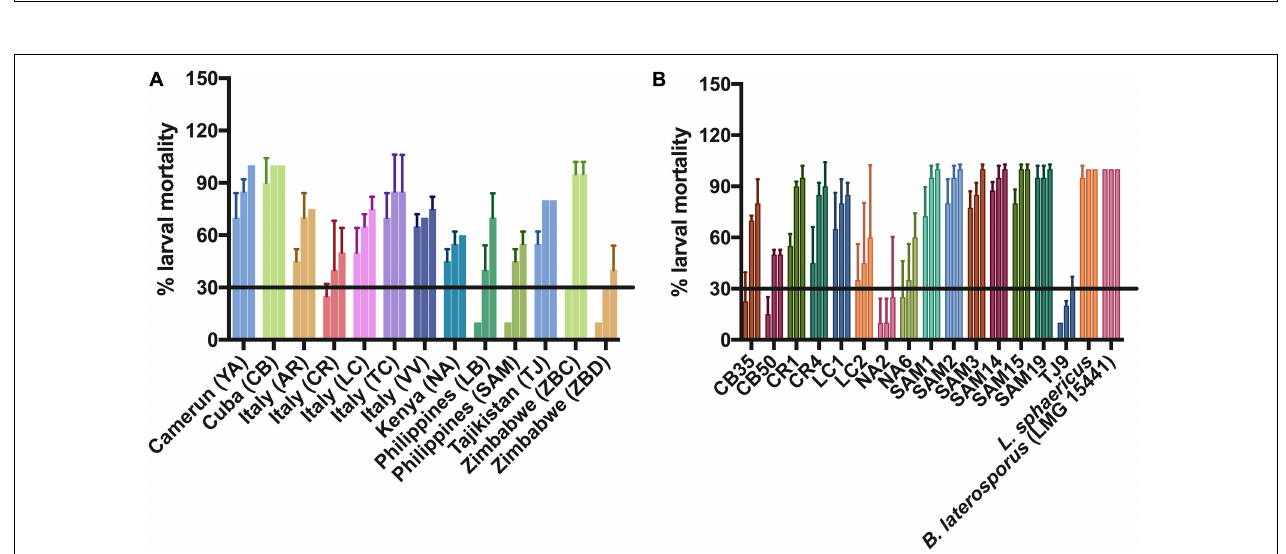
FIGURE 2 | Percentage of Ae. albopictus larval mortality at 24, 48, and 72 h after treatment with mixtures of cells and spores of cultures originating from the inoculum of 13 soil samples (A) or of single bacterial isolates (B) . Suspensions were added at the final concentration of 2 g/L. For each sample, the first, second and third bar represent larval mortality at 24, 48, and 72 h, respectively. Under the employed conditions, treatment with B. laterosporus strain LMG 15441 induced 100% of larval mortality in all experiments [Standard deviation (SD) = 0]. Data are the average ± SD of two independent experiments, each performed in duplicate.